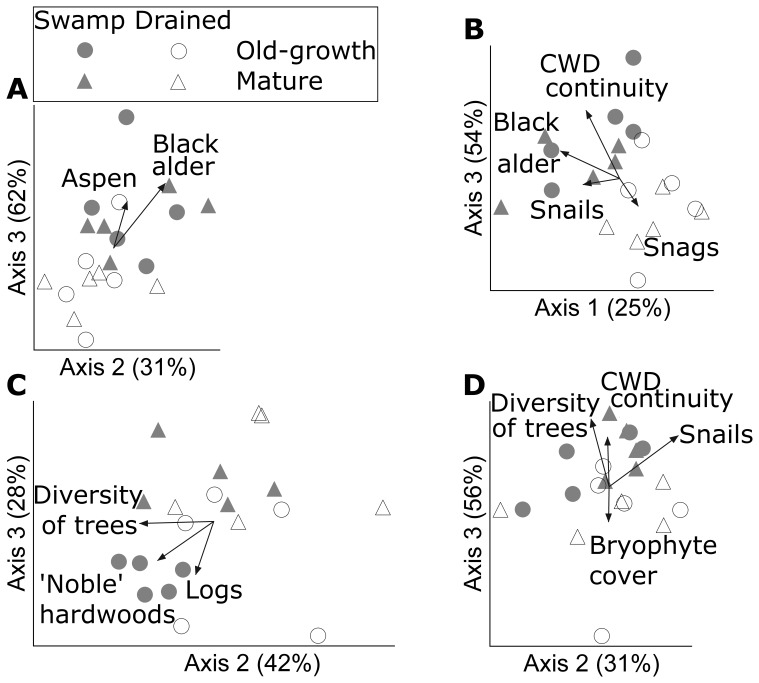
NMS ordination diagrams of the species’ assemblages in forest plots.(A) herbs and dwarf shrubs, (B) bryophytes, (C) lichens, (D) snails. The two most representative axes (% variance explained indicated in titles) of the 3-dimensional solutions and environmental factors correlated with these axes at combined r2>0.2 are shown (all factors are listed in Table S5). Note that the factor ‘Snails’ refers to total snail abundance.